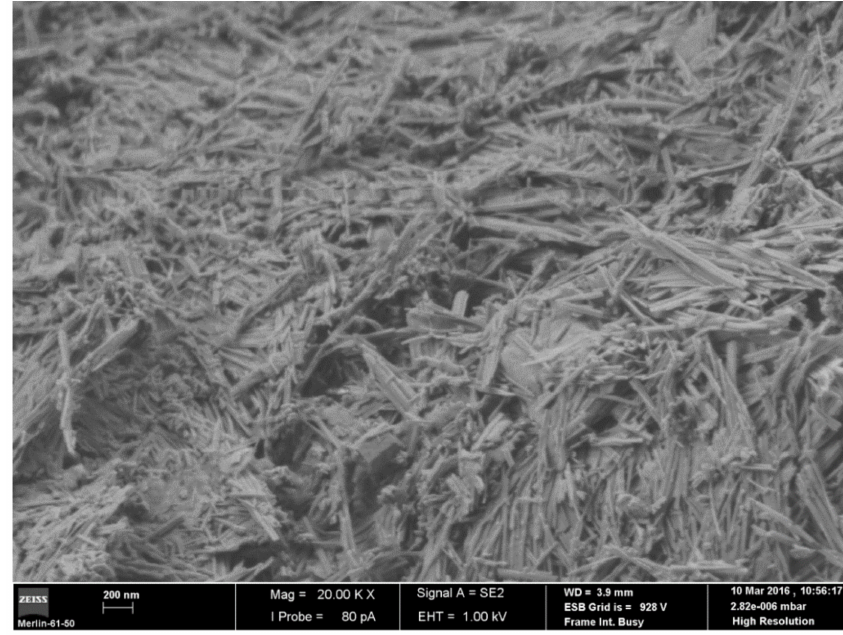
Figure 2. FE-SEM microphotograph of the palygorskite ( × 20,000).